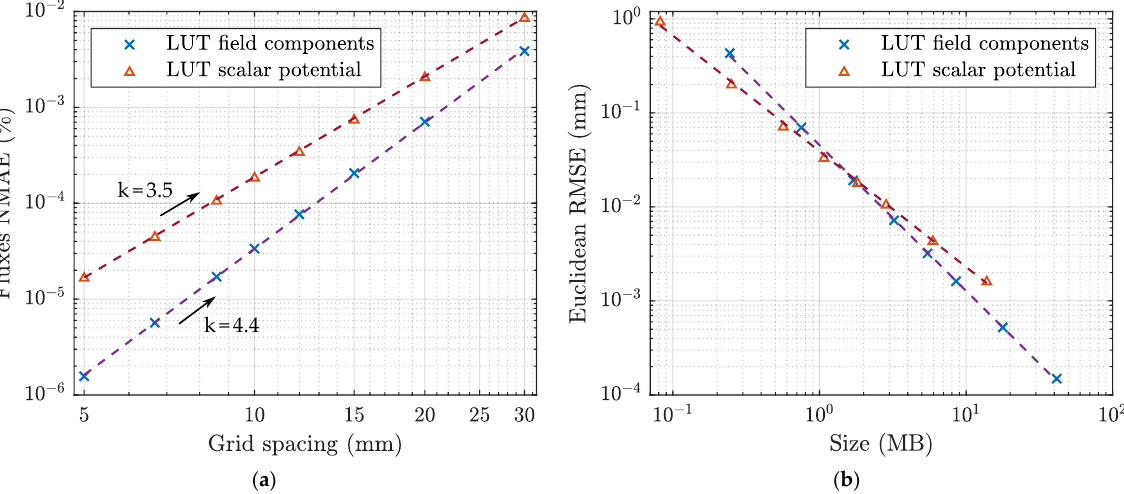
Figure 5. ( a ) Interpolation error and ( b ) correspondent position tracking error as a function of the table size, for two tabulated models compared. In one case, the three magnetic field components are stored independently and the fluxes are obtained from Equation (3), in the second case, the magnetic scalar potential is saved at grid-points and the fluxes are calculated from Equation